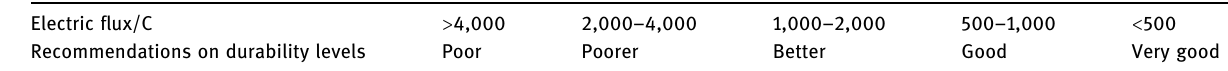
Table 6: Concrete electric fl ux evaluation index [ 22 ]